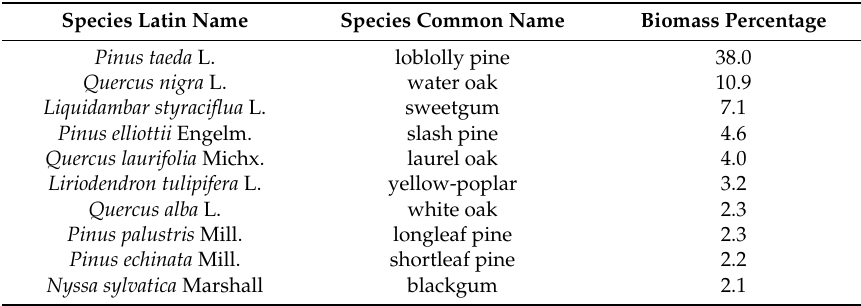
Table 2. The top ten most abundant species in the Gulf Coastal Plains ecological section by percentage of total aboveground biomass as reported by the U.S. Forest Service Forest Inventory and Analysis estimate from plots sampled between the years